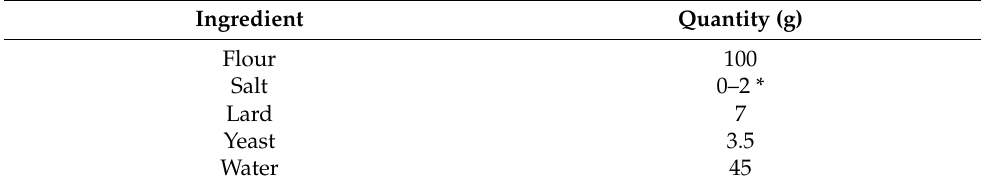
Table 1. Formulation of